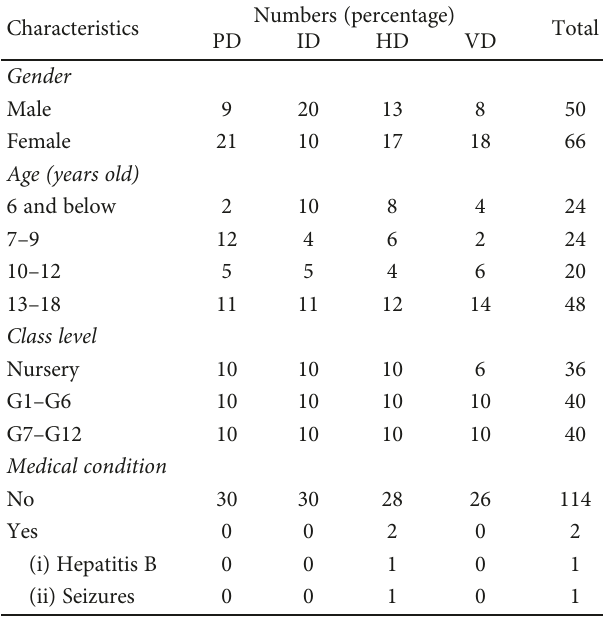
Table 2: Characteristics of children with disabilities ( n = 116